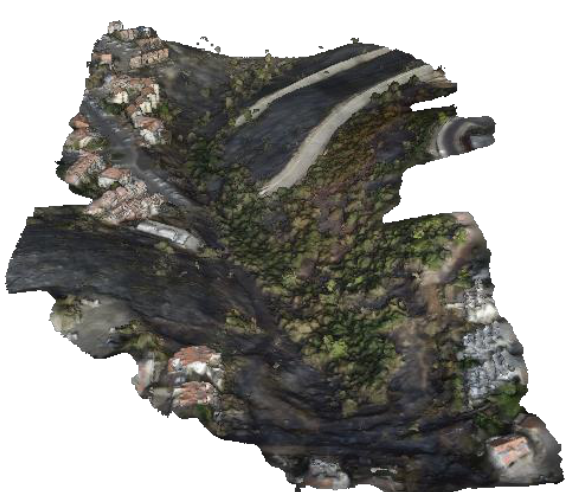
Figure 7. Temporal orthomosaics data collected by UAV, left top corner 1 day after the fire event, right top corner 3 days after the event, left bottom corner 1.5 weeks after the event, right bottom corner 2 weeks after the event